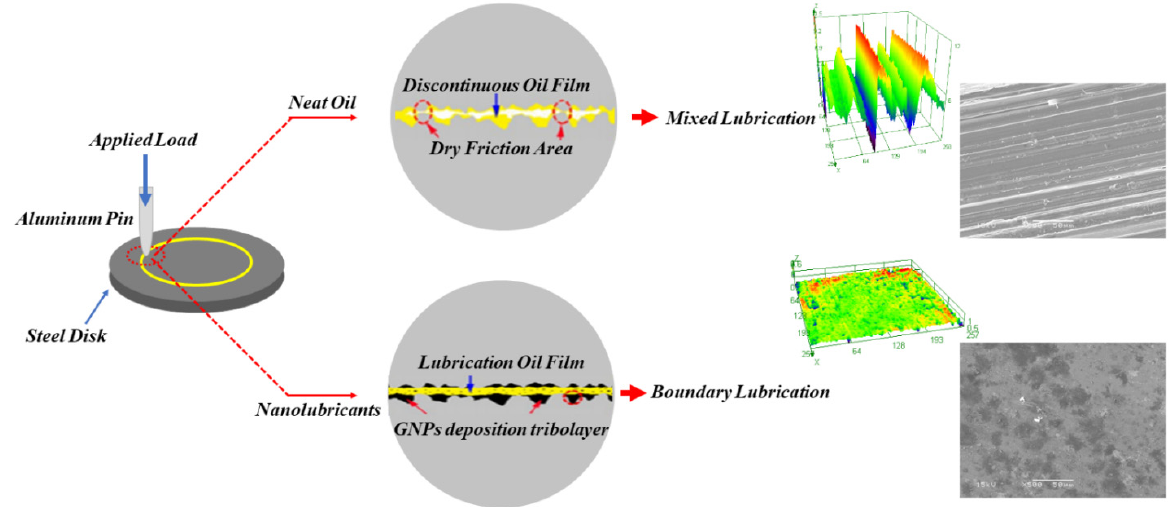
Figure 16. Schematic of the lubricating models of the neat oil and the nanolubricants.